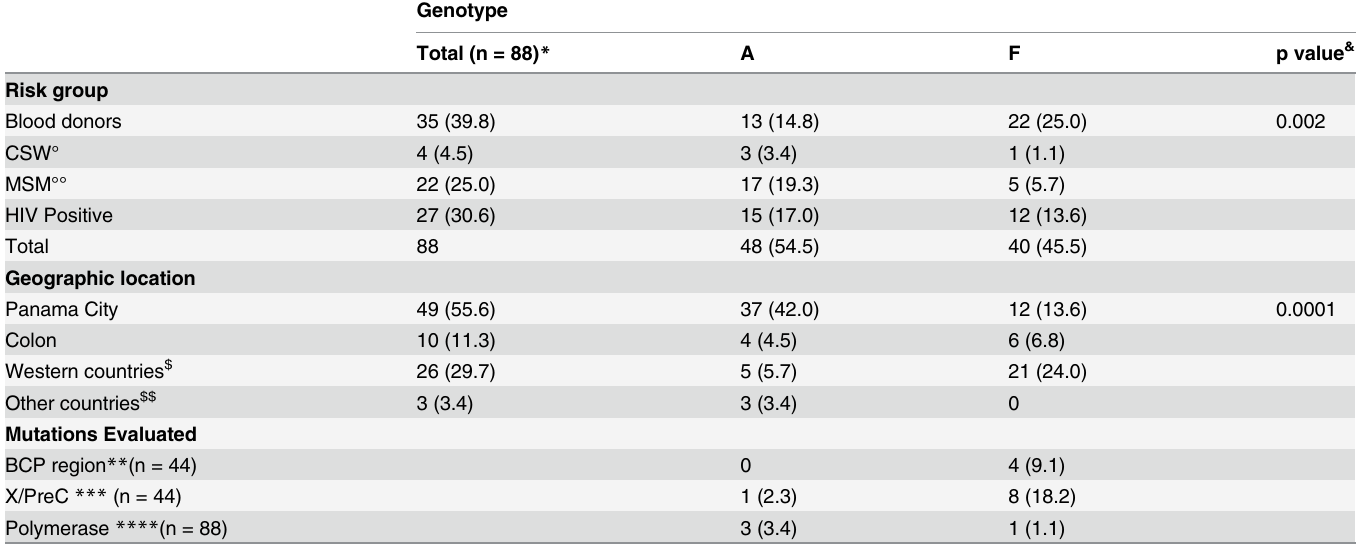
intervals Table 3. The analysis of tMRCA of genotype F confirms previous estimates of tMRCA for each sub-genotype (Table 3), but when Panamanian samples of sub-genotype F1a were evaluated (F1a pan in Table 3), we observed younger tMRCA compared with others genotype